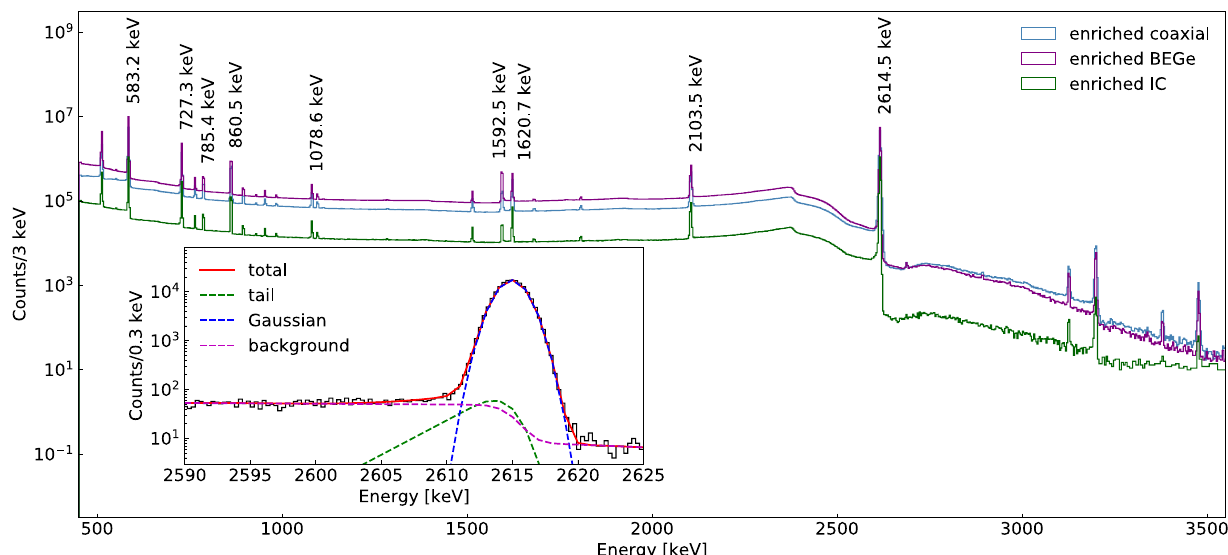
with the components of the fit drawn separately (linear and step back- grounds are combined). The energies of the nine peaks that typically contribute to the formation of calibration curves are